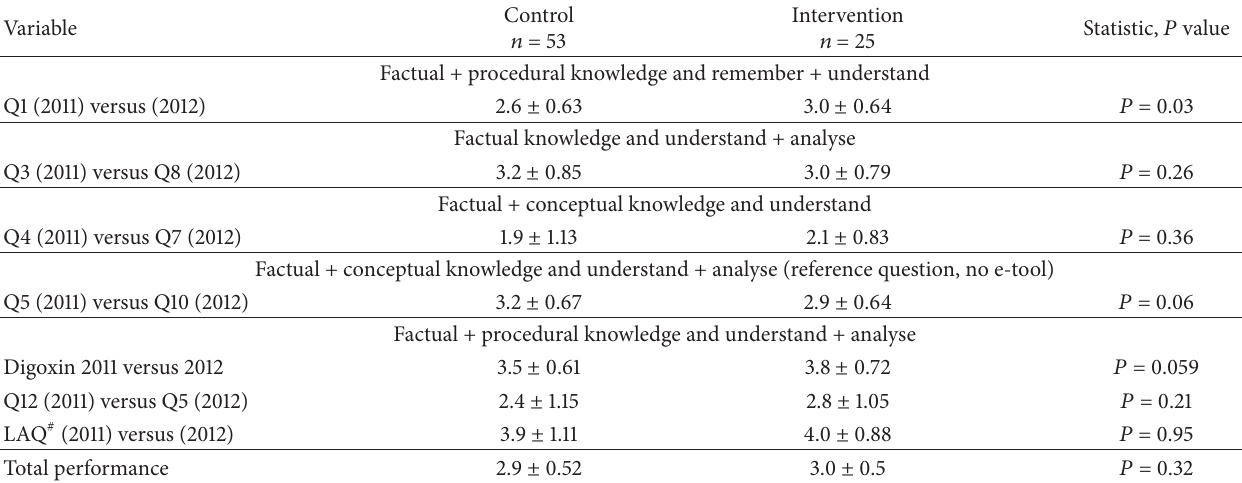
Table 4: Student level of understanding in semester one exams.